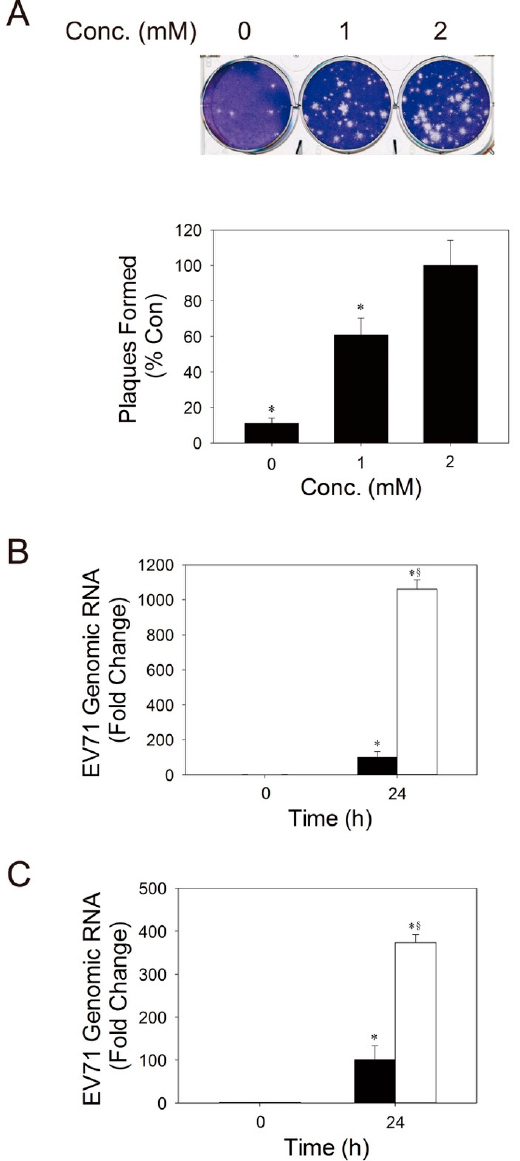
Figure 5. Glutamine and DM- α KG are essential to viral replication. ( A ) Vero cells were infected with EV71 in the medium containing the indicated concentrations of glutamine for 1 h, and were overlaid with 0.3% agarose in MEM/2% FCS, supplemented with the indicated concentrations of glutamine. The infected cells were processed for crystal violet staining as described in Materials and